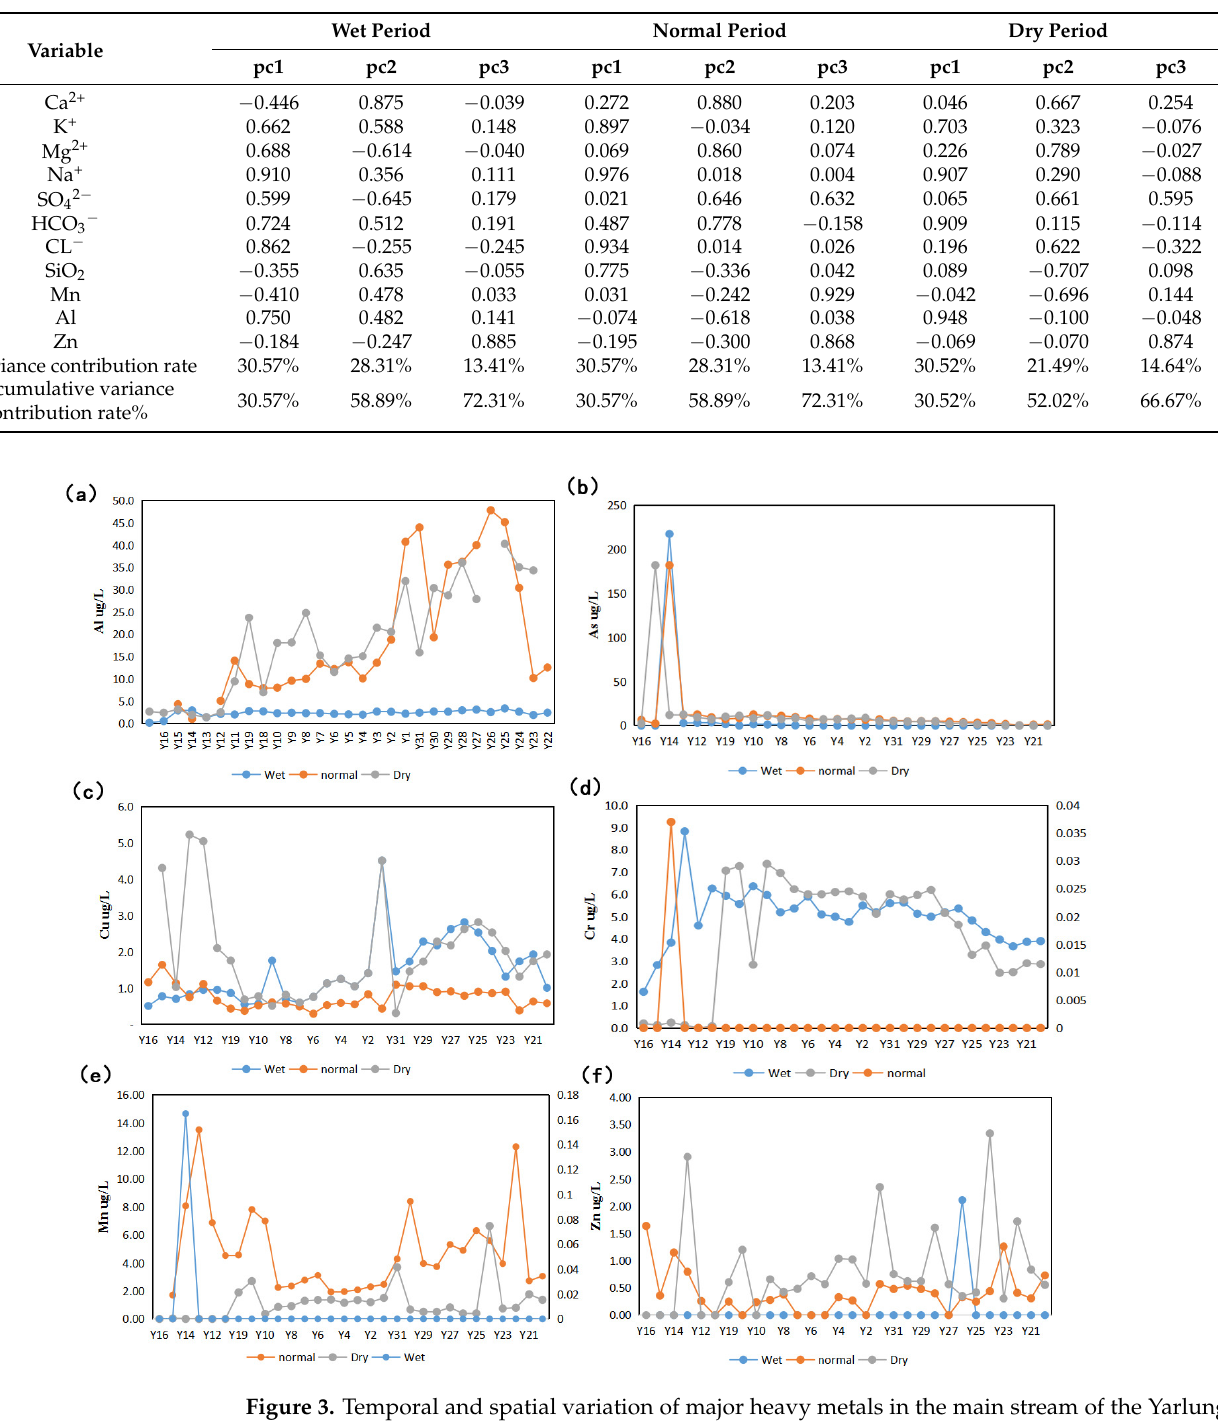
Table 3. Principal component analysis (PCA) of elements in river waters.